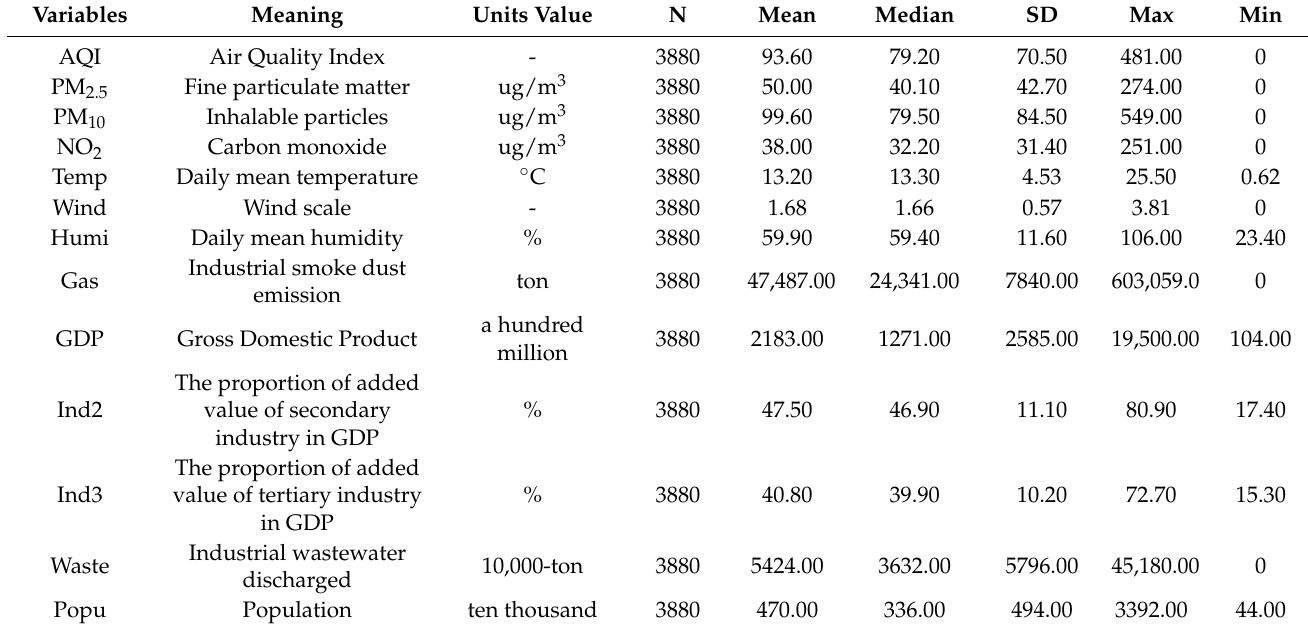
Table 1. Description of variables and data.